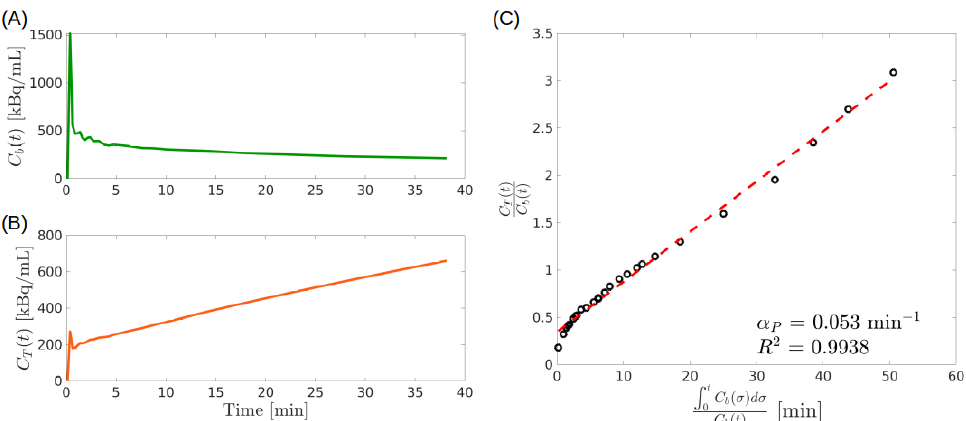
Figure 3. Illustrative example of the Patlak graphical approach. ( A ) Experimental input function C b ( t ) as a function of time. ( B ) Simulated total concentration C T ( t ) as a function of time. ( C ) Patlack plot (black circles). The red dotted line is the results of a linear regression model fitted to the points of the plot. The value of the corresponding slope α P and of the coefficient of determination R 2 are also